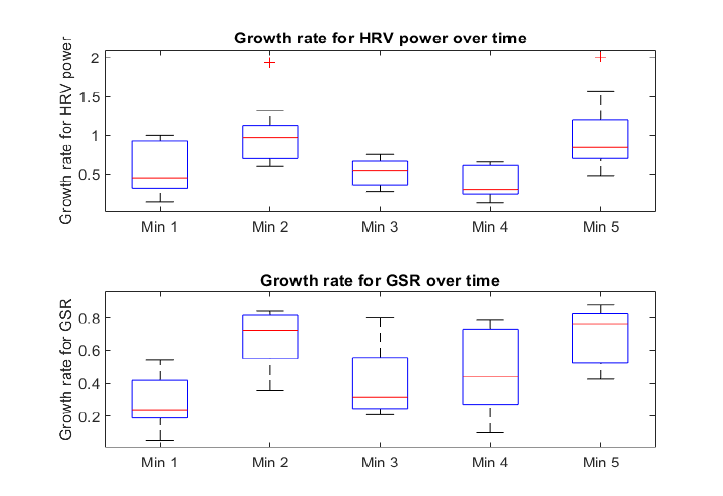
Figure 13. Experiment 2 Box plot for growth rate of HRV power and GSR.